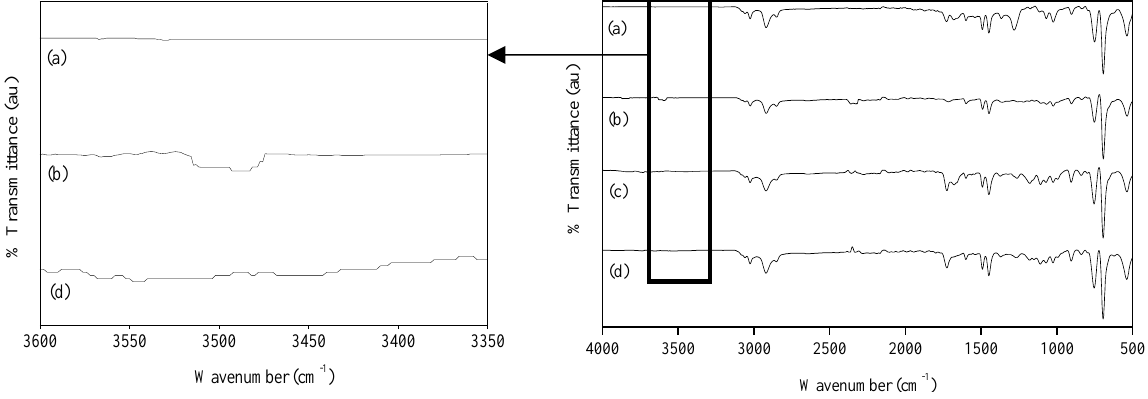
Figure 1. FT-IR spectra of the different synthesized particles: St-DVB (a), St-DVB-PEGMA (b), St-DVB-GMA (c), and St-DVB-GMA- PEGMA (d). Full spectra ( left ); Detail of the FT-IR in the range 3350 – 3600 cm − 1 ( right ).